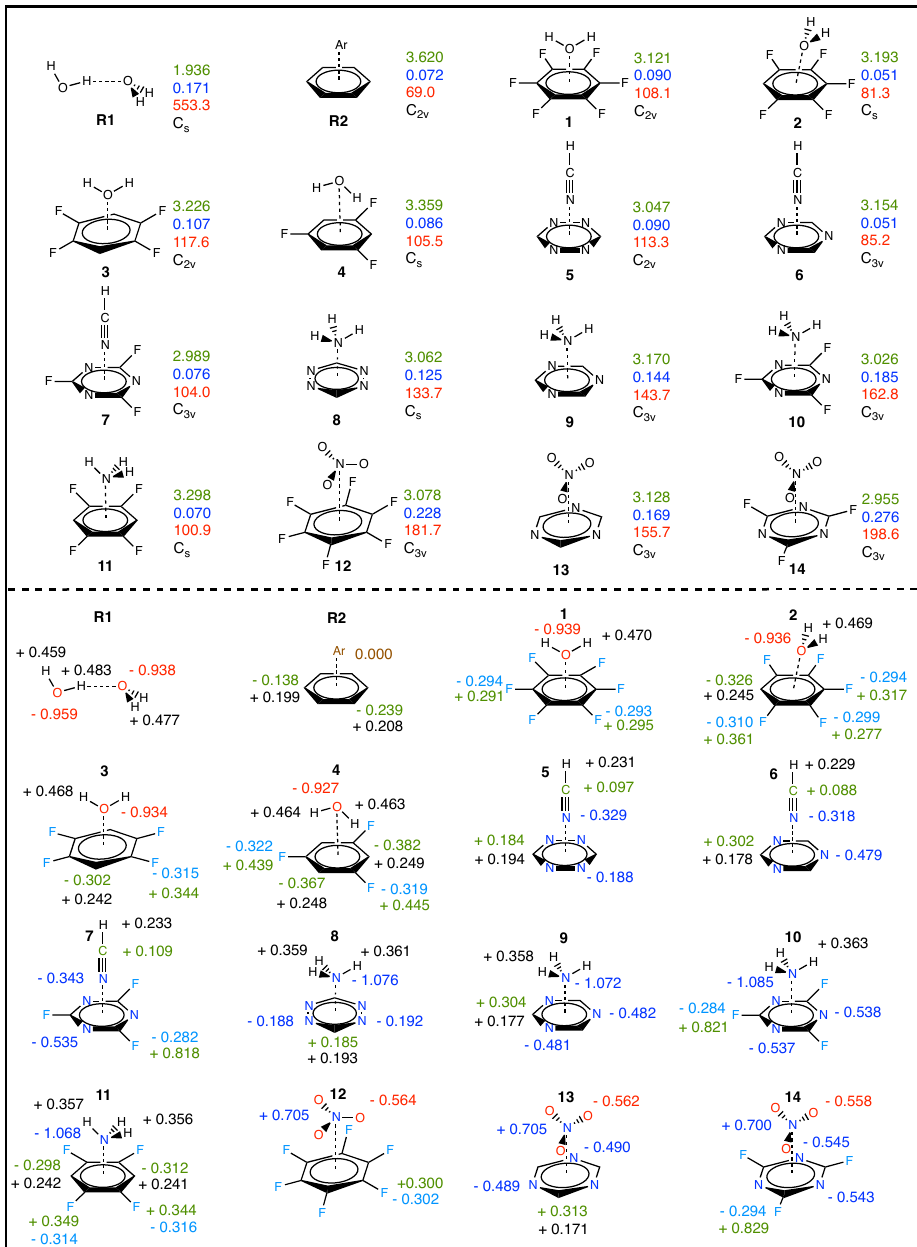
Figure 3. Schematics for R1 , R2 , and 1–14 , showing: ( top ) molecular geometries, distances r given in green font with units of Å, local vibrational mode LVM force constants k a (blue font) given in mdyn/Å, corresponding LVM frequencies ω a (red) given in cm − 1 , point group (shown in black); and ( bottom ) selected NBO charges: C–atomic charges given in green, O–atomic charges in red, N–atomic charges in blue, F–atomic charges in light blue, and H–atomic charges are shown in black. NBO charges are given in